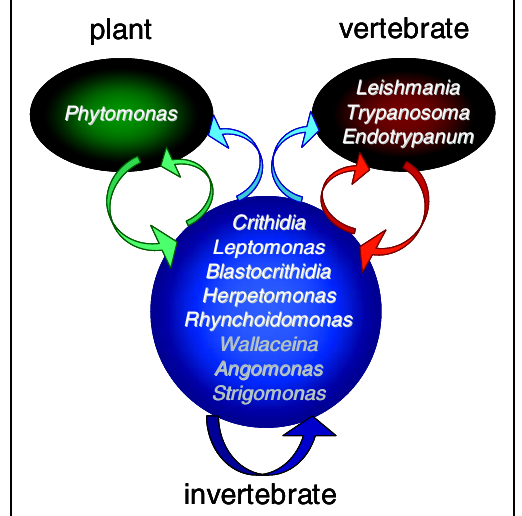
Fig. 1 – The life cycles of the trypanosomatid genera. In the heteroxenous ones, trypanosomatids alternate between an inver- tebrate host and vertebrates (red arrows) or plants (green arrows). The development of monoxenous genera occurs in a single inver- tebrate host (dark blue arrow), although insect trypanosomatids canbefoundinplantsandrecentreportedcasesdescribethepres- ence of these trypanosomatids in vertebrates (light blue arrows). The insect trypanosomatid genera highlighted in grey were re- cently